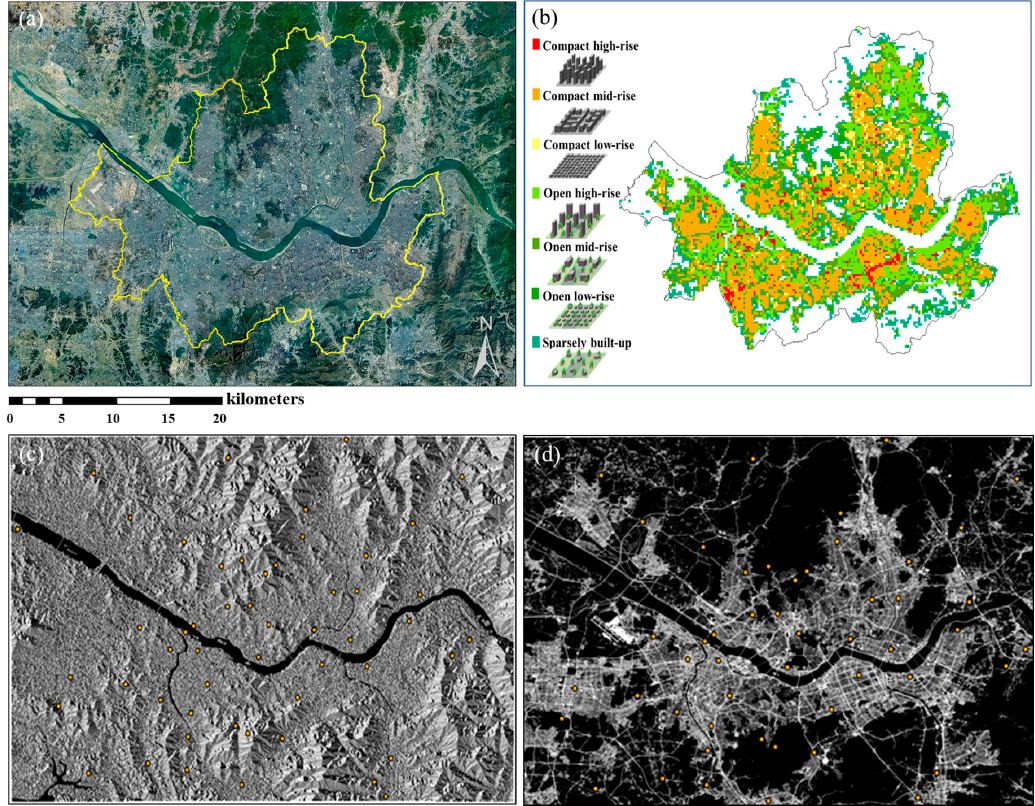
Figure 1. Topographic and land cover characteristics of Seoul. ( a ) Aerial photograph (yellow line denotes the administrative boundary of Seoul); ( b ) local climate zone (LCZ) types of land surfaces with building footprints; ( c ) shaded relief map; and ( d ) street networks (white) and automated weather stations (AWSs; yellow dots).